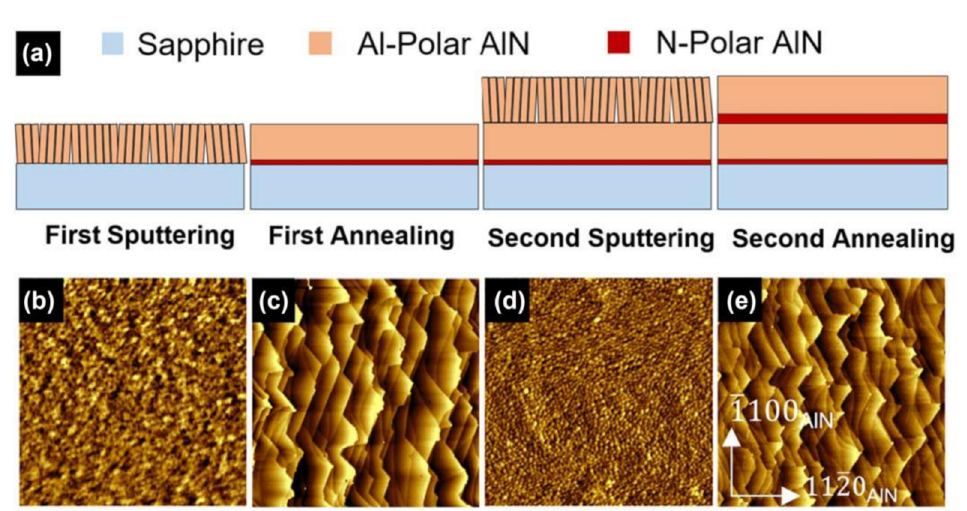
Figure 15. ( a ) Schematic diagrams of the double sputtering and annealing process. ( b – e ) Plan-view AFM images of AlN/sapphire template at different stages. Reprinted from [74]. Copyright (2020) The Japan Society of Applied Physics.